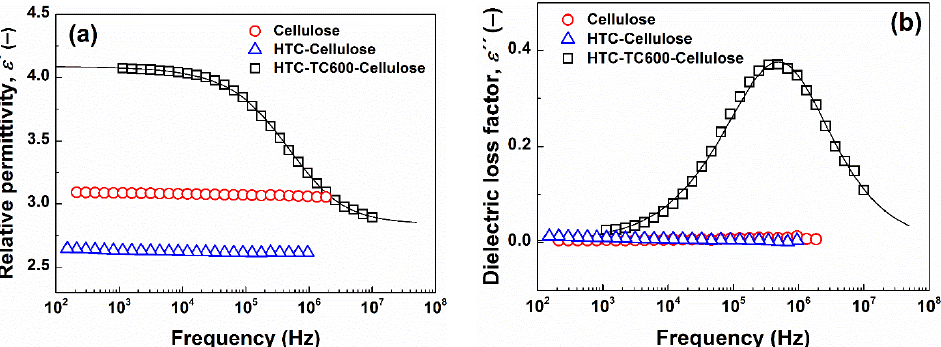
Figure 8. The frequency dependence of relative permittivity, ε ’ ( a ) and dielectric loss factor, ε ´´ ( b ), for 5 wt% silicone oil ER suspensions based on prepared particles. Solid lines represent the Havriliak–Negami model fit.